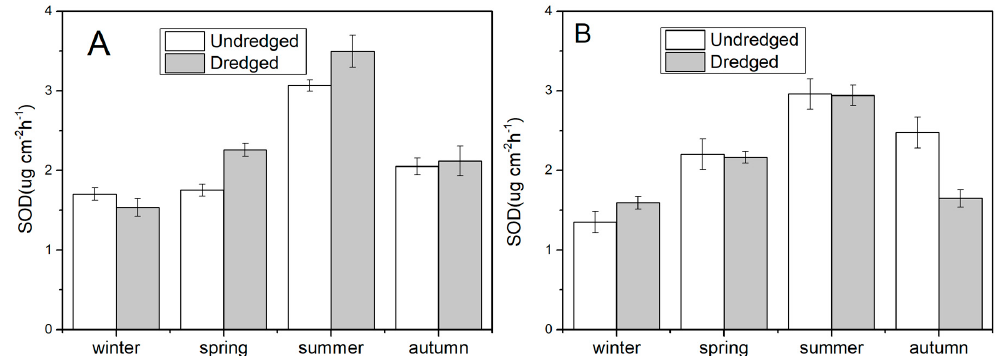
Figure 6. Sediment oxygen demand (SOD) in undredged and dredged sediments of the Inner Bay ( A ) and Outer Bay ( B ) in January, April, July, and October 2013, Error bars represent ±1 SE of triplicate samples.